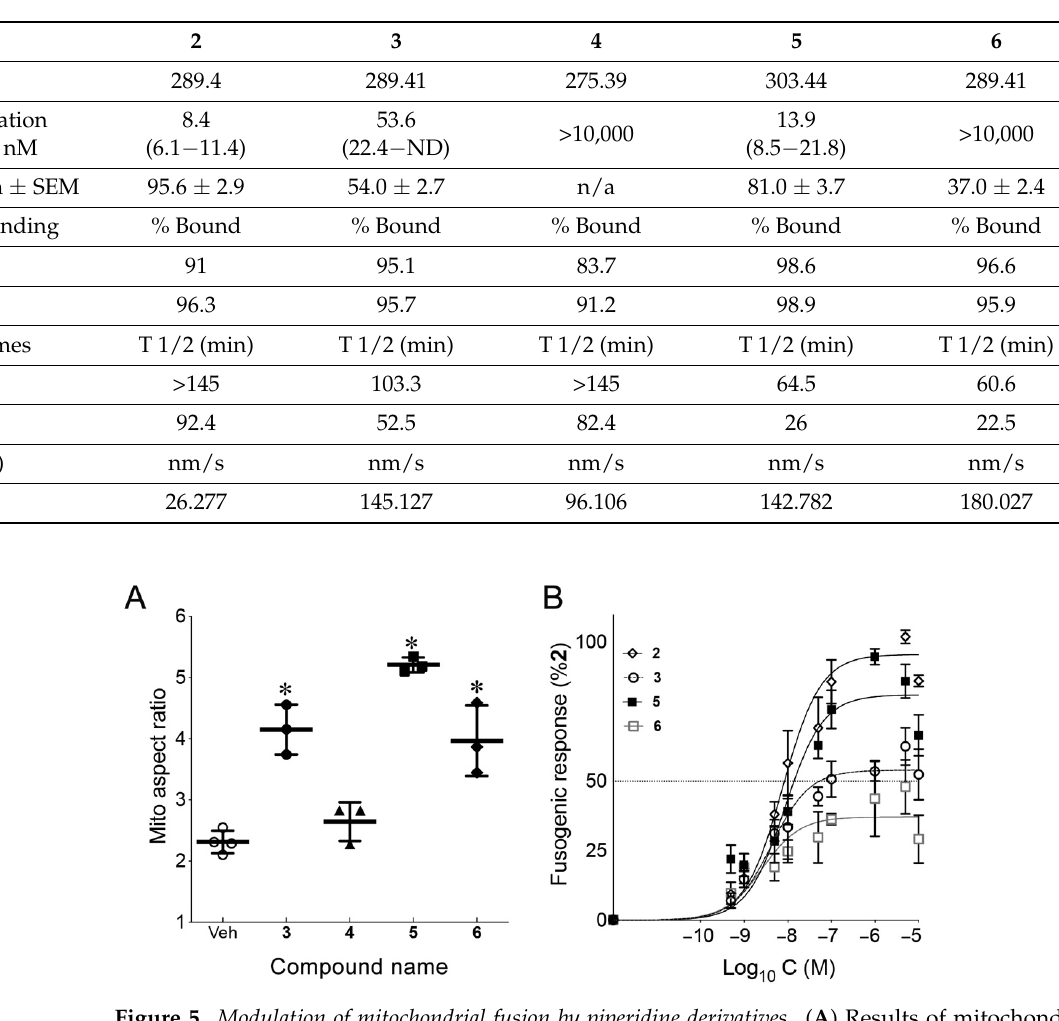
Figure 5. Modulation of mitochondrial fusion by piperidine derivatives . ( A ) Results of mitochondrial elongation screening assays performed in Mfn2-null MEFs using 1 µ M of each piperidine derivative. ( B ) Concentration-dependent mitochondrial elongation of active compounds in Mfn2-null MEFs. EC 50 with 95% CI and E max values are in Table 2. * = p < 0.05